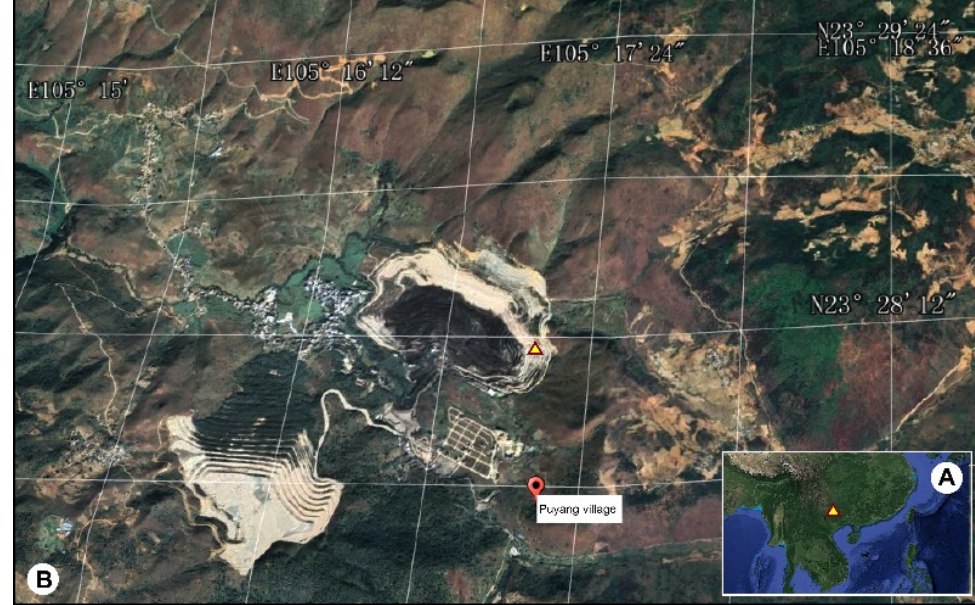
Figure 2. The position of the fossil locality in a broad view of southeastern Asia ( A ) and in a magnified view of Puyang Basin, Yunnan province, China ( B ).